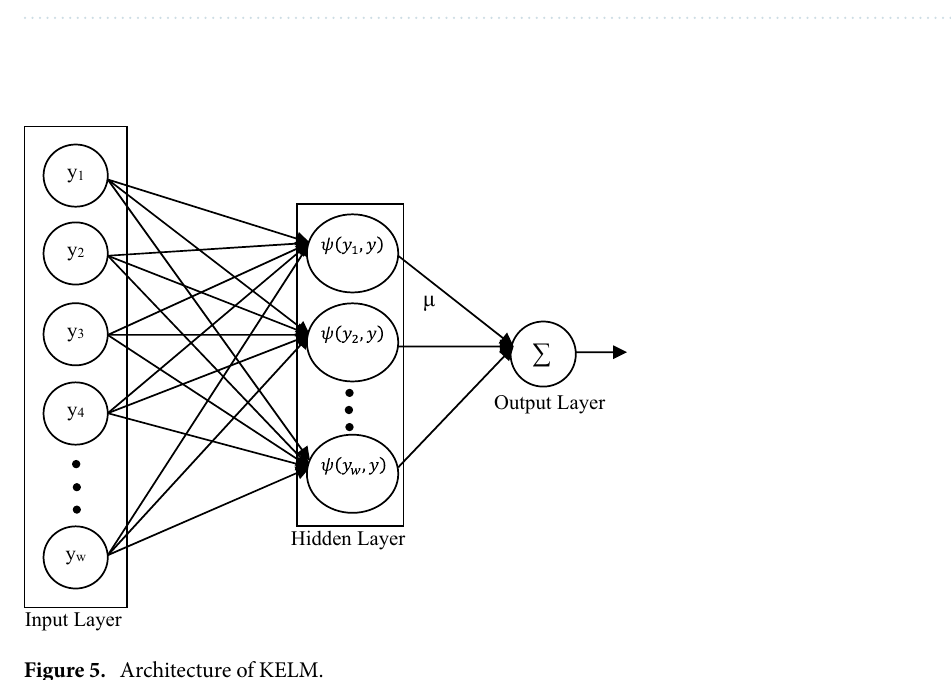
Figure 5. Architecture of